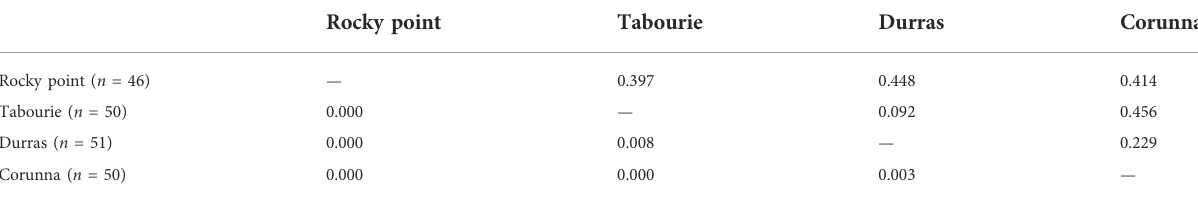
TABLE 2 Pairwise population differences measured using PhiPT values among four eastern king prawn populations using samples collected before stocking.PhiPTvaluesareshownbelowdiagonal,andthestaticalsigni fi canceofthesevaluesare(probability,basedon999permutations)shown above diagonal. No samples from Wallagoot were available before stocking. n = sample